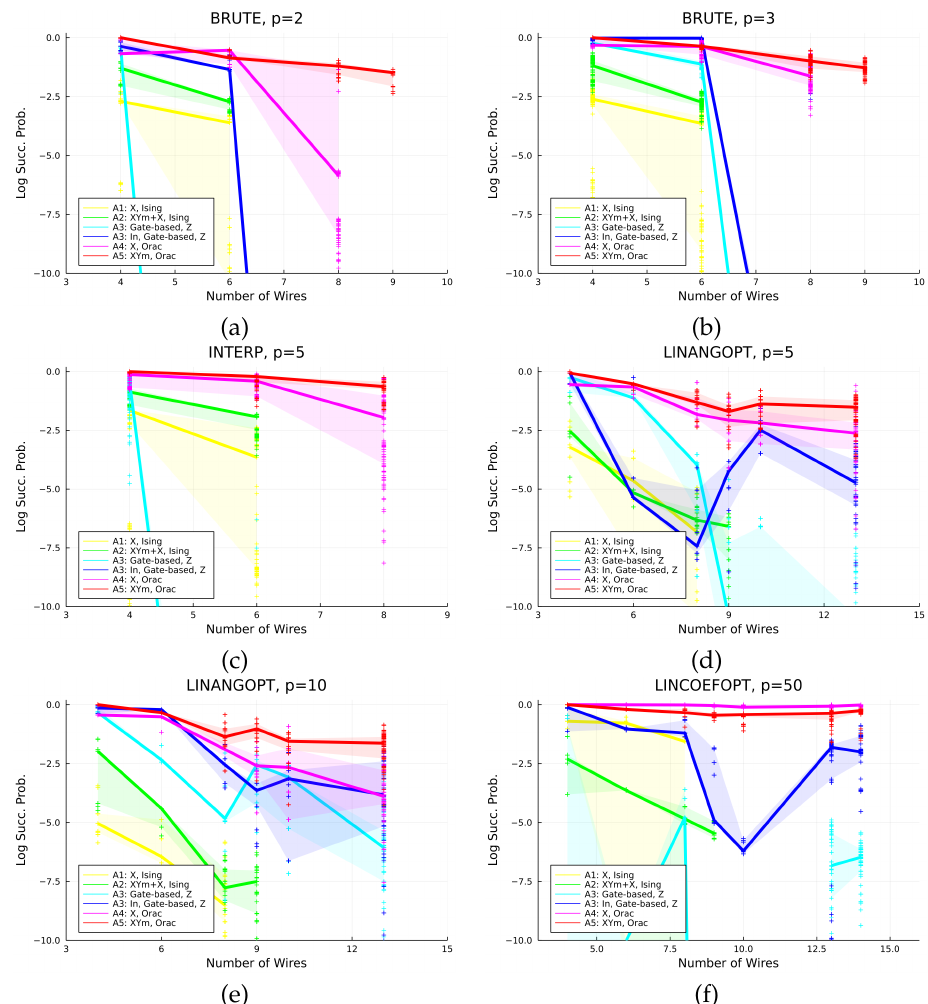
Figure 4. Performance of ansätzes with different parameter selections. The solid lines indicate the performance on the median of the instances, while the ribbons correspond to the lower and upper quantiles. Markers correspond to the success probabilities of individual